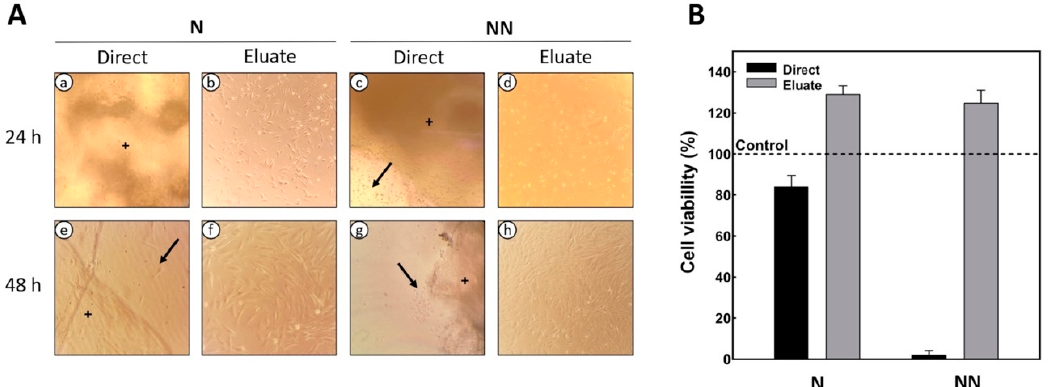
Figure 5. Microphotographs (inverted light) and viability of cultured DPSCs following direct or indirect contact with chitosan/AH. ( A ) Phase-contrast micrographs of DPSCs with direct or eluate contact at 24 and 48 h on neutral (N) and non-neutralized or alkaline (NN) scaffolds over 48 h. ( B ) MTT assay of DPSCs’ viability on N and NN scaffolds after 48 h of culture. The arrows point to the cells attached to the culture surface; +: sponge fragment in the microscope field.